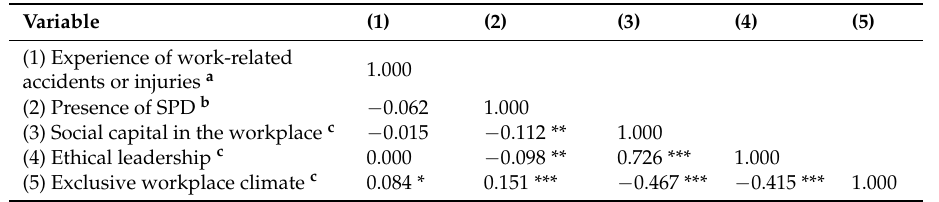
Table 4. Spearman’s correlation coefficients between dependent variables and SEW subscales ( n = 822) a .